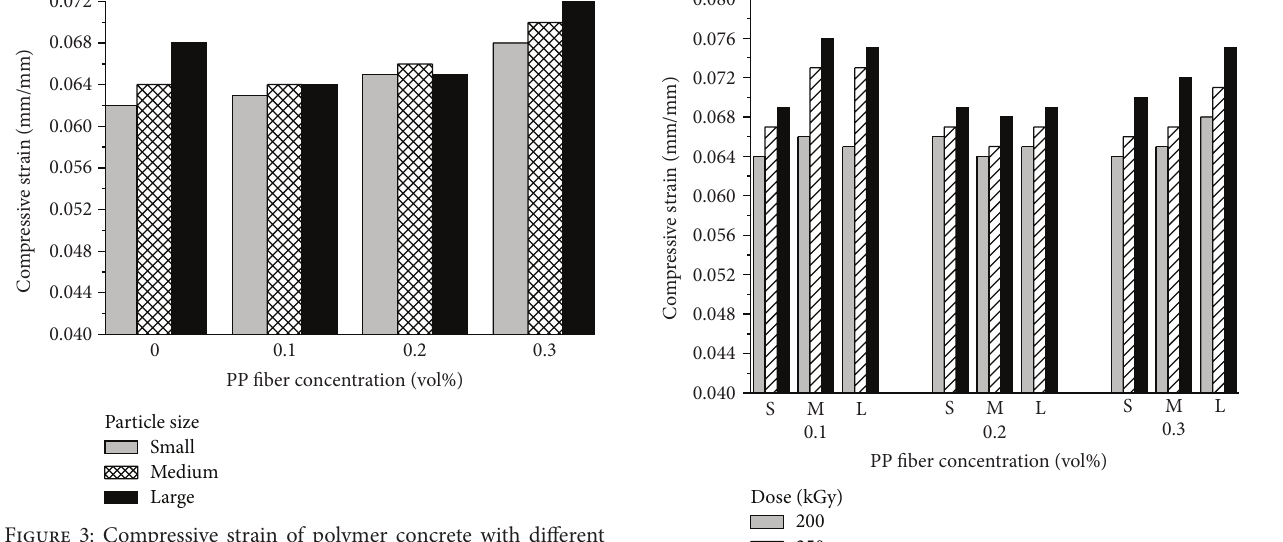
Figure 3: Compressive strain of polymer concrete with different marble particle sizes and fiber concentrations.